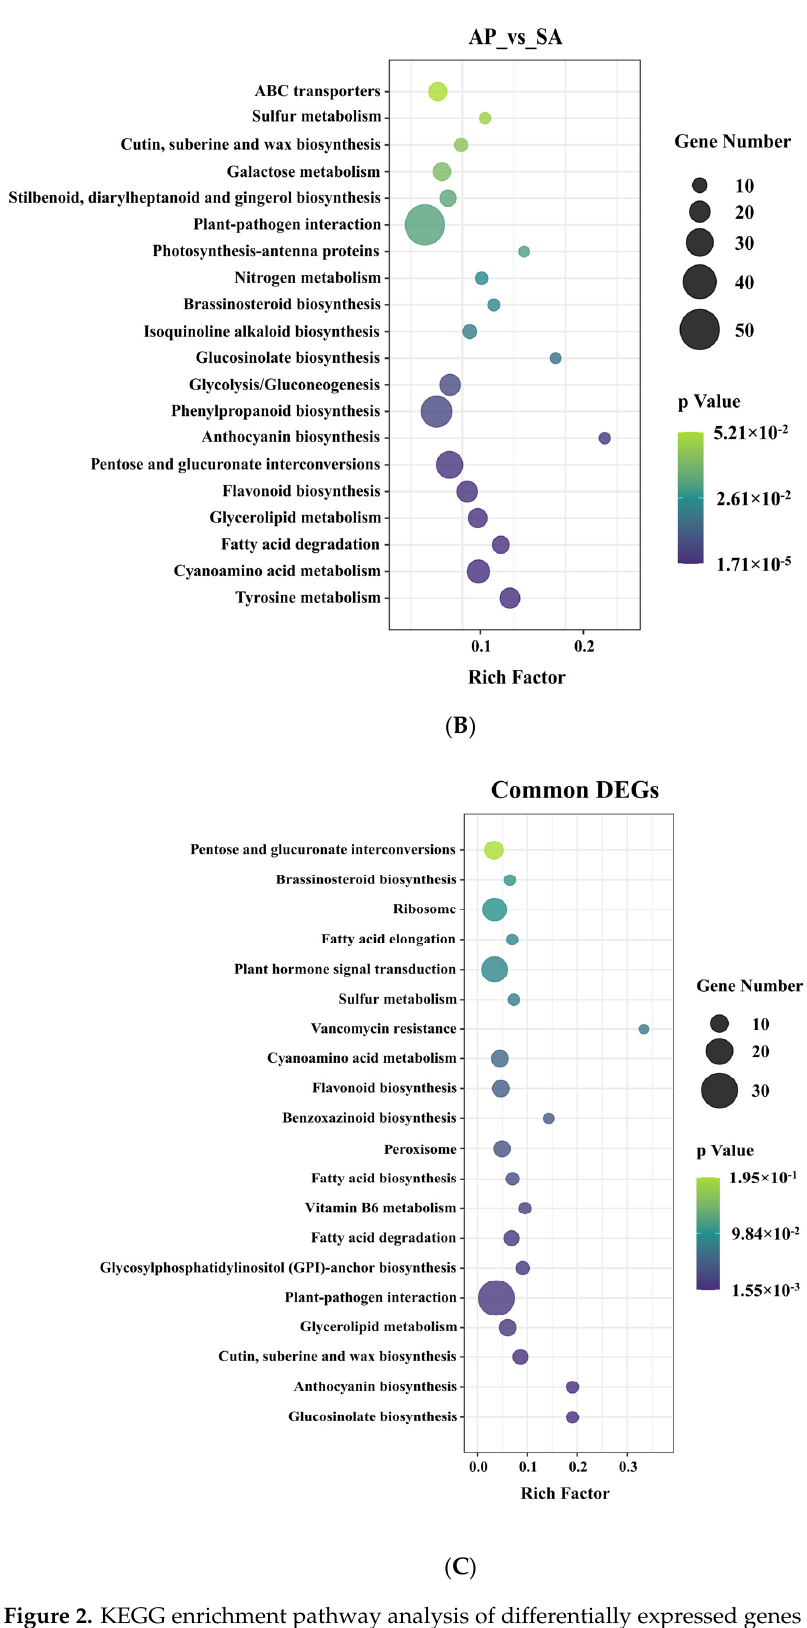
Figure 2. KEGG enrichment pathway analysis of differentially expressed genes (DEGs) in grafted apricot hybrids. ( A ) DEGs enriched in KEGG pathways in peach/apricot (PA); ( B ) DEGs enriched in KEGG pathways in apricot/peach (AP); ( C ) common DEGs enriched in KEGG pathways in peach/apricot (PA) and apricot/peach